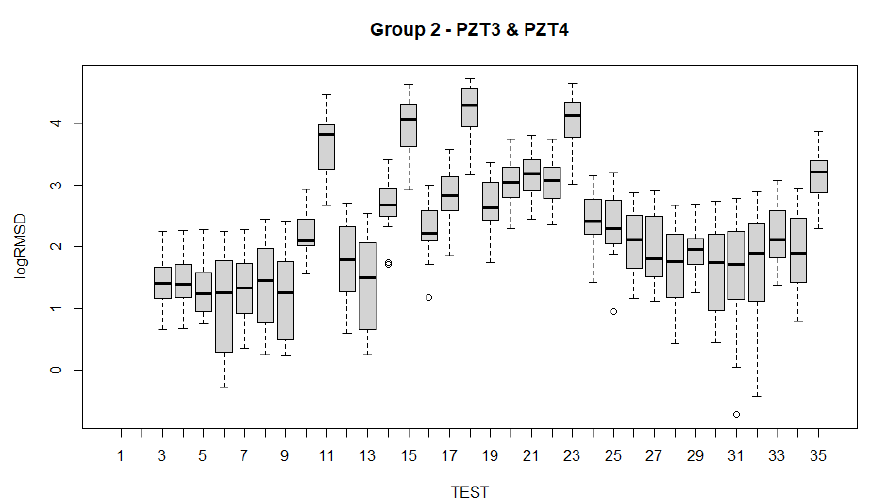
Figure 19. Boxplot for sensors of group 2.